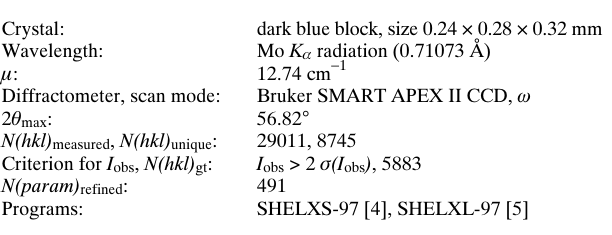
Table 1. Data collection and